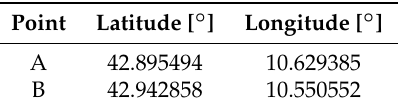
Figure 7. Map showing the positions of the end node, point A, and of the Gateways, point B along with the covered distance, red line. Table 1. Coordinates of points A and B of Figure